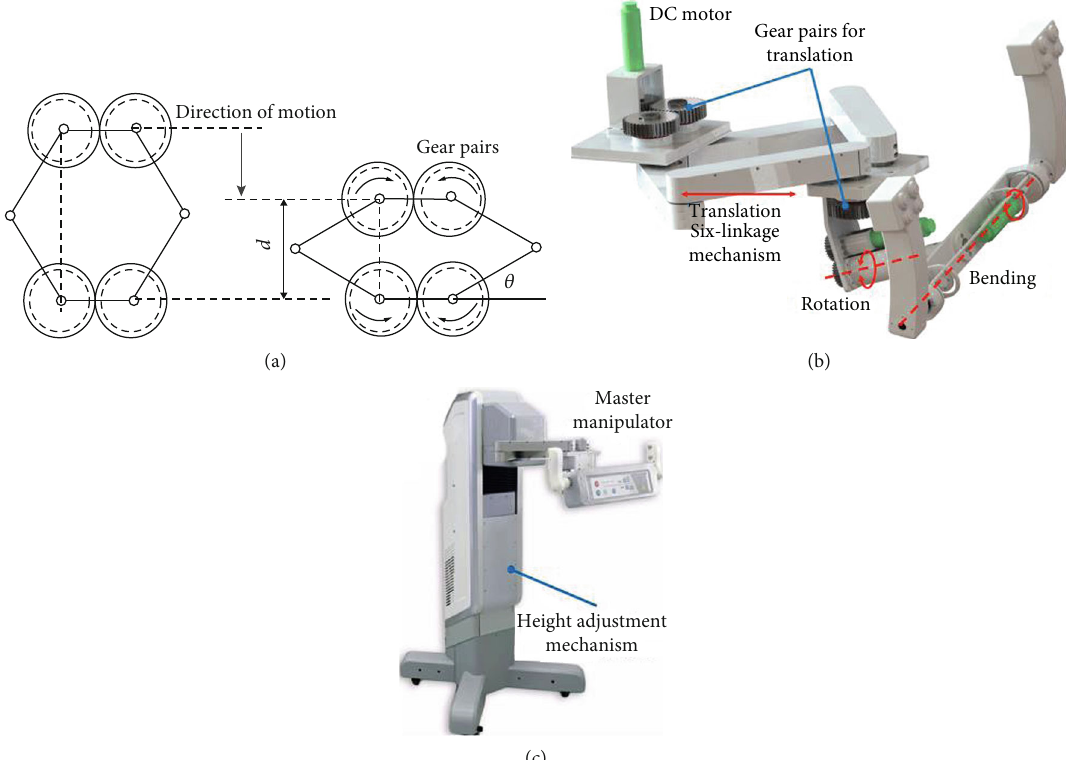
Figure 4: (a) Schematic diagram of the six-linkage mechanism to realize translation by rotation; (b) the design details of the master arm; (c) the mechanical design and con fi guration of the